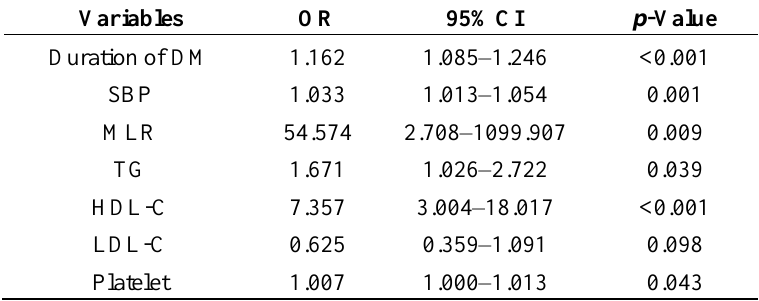
Table 3. Logistic regression analysis showing independent predictors of